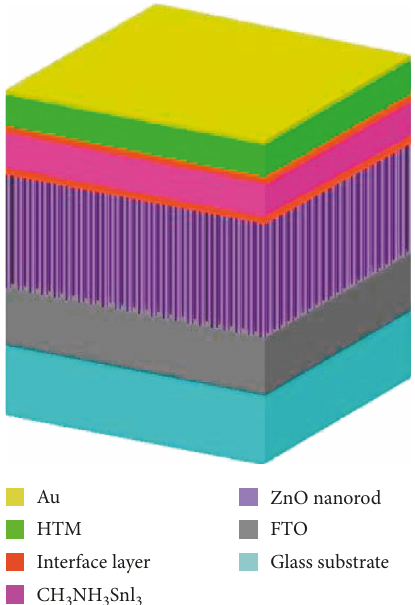
Figure 1: Device structure of Pb-free perovskite solar